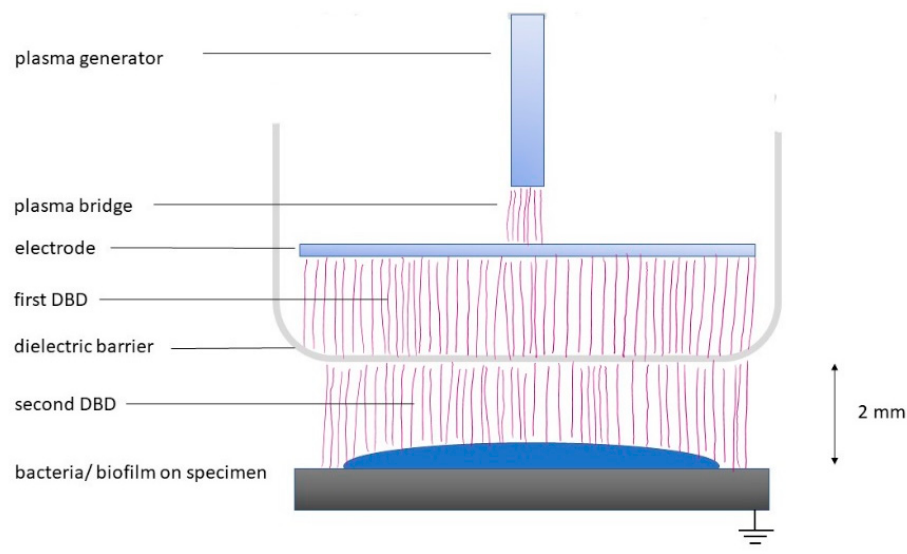
Figure 1. Experimental set-up for the effect on planktonic bacteria and biofilms; DBD: dielectric barrier discharge .